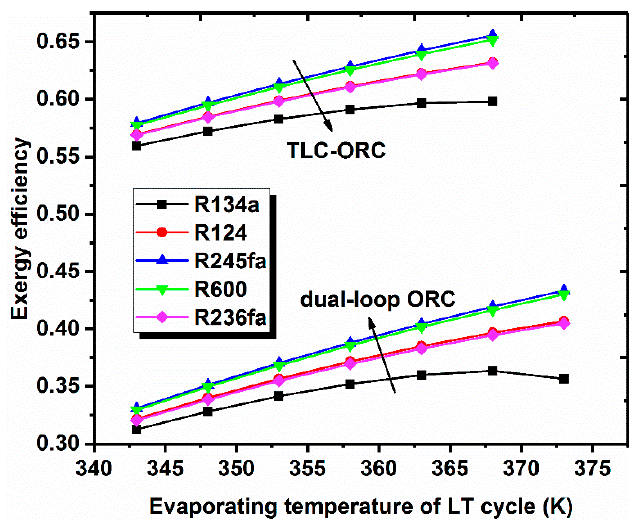
Figure 14. Comparison of exergy efficiency between the two configurations under different exhaust inlet temperature.